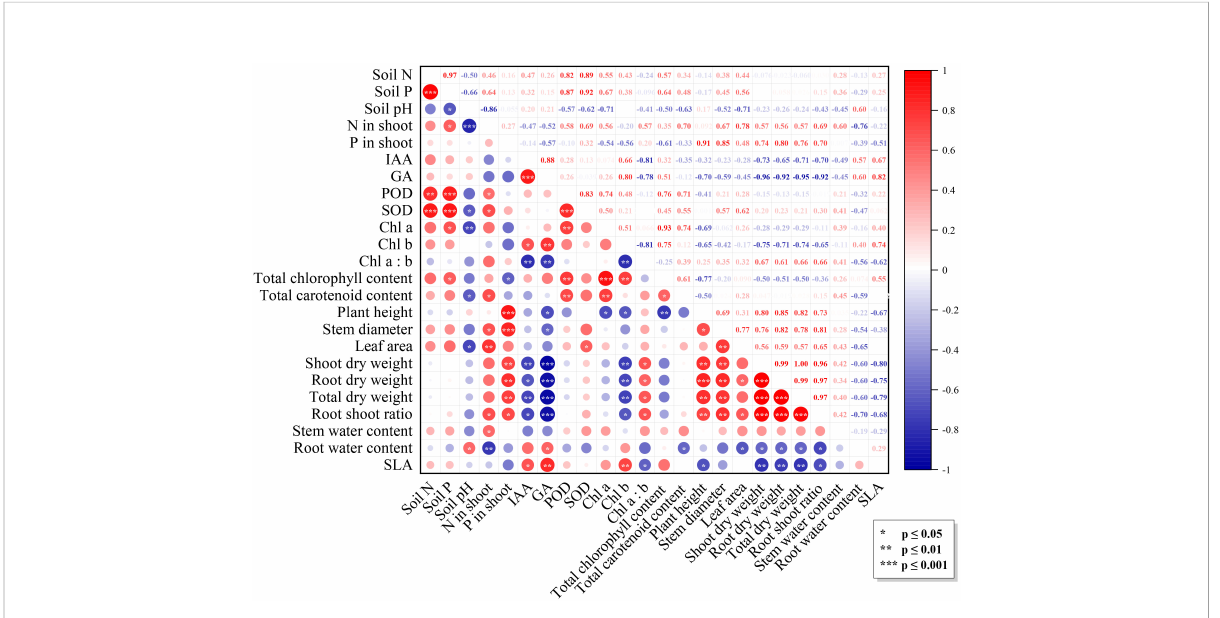
FIGURE 3 Correlation matrix of the factors. The upper triangular part of the graph is the correlation coef fi cient matrix, the lower triangular part is the graphical indication, with the diameter of the dots denoting the values of the correlation coef fi cients: positive and negative correlations are indicated by colors, and signi fi cance levels are indicated by